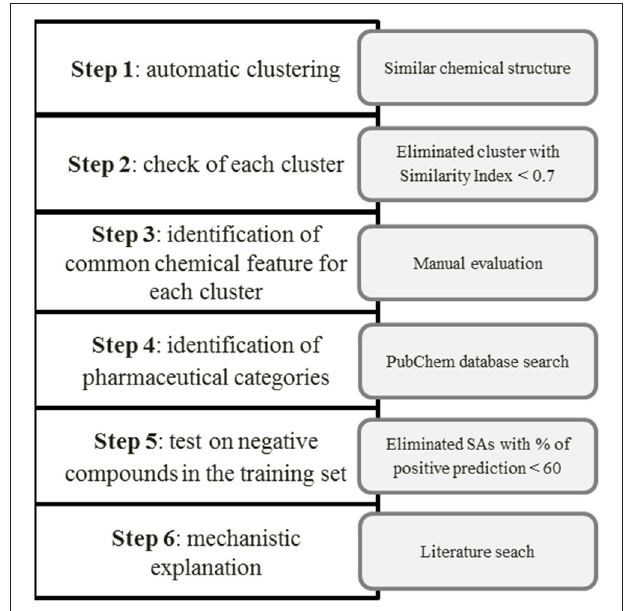
FIGURE 1 | Identification and validation of SAs for